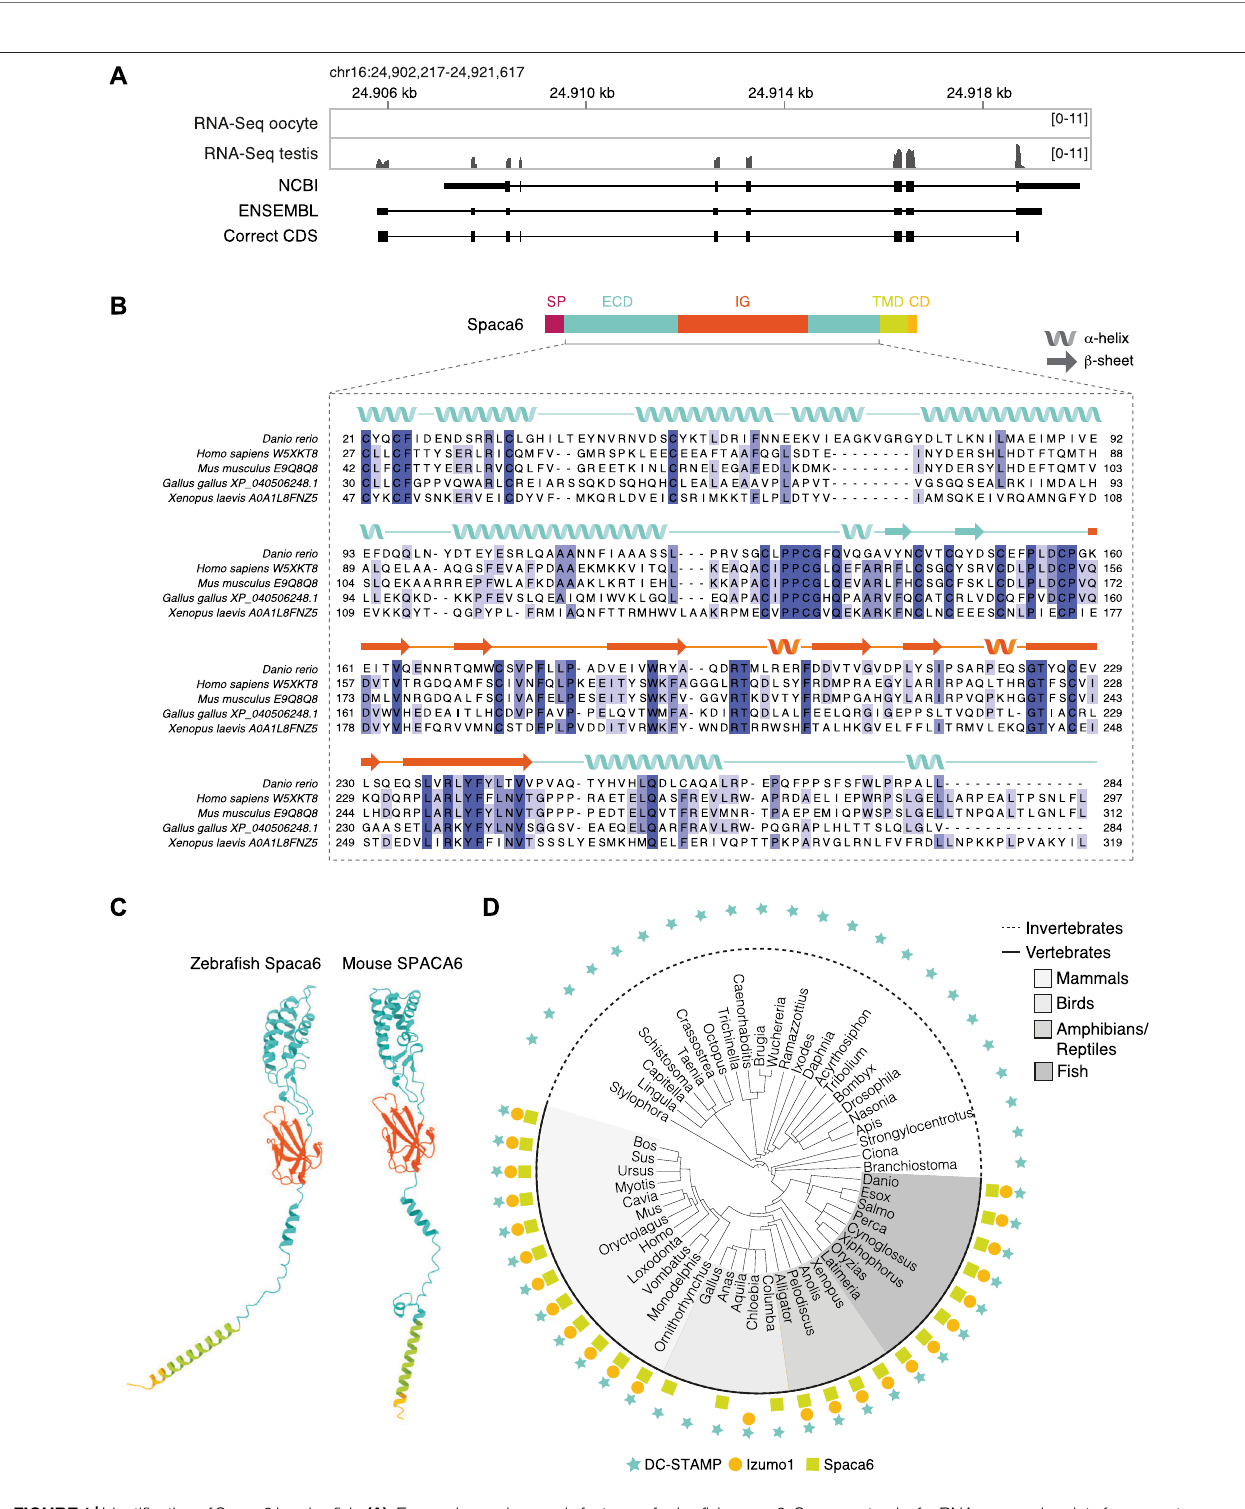
FIGURE1| Identi fi cationofSpaca6inzebra fi sh. (A) .Expressionandgenomicfeaturesofzebra fi sh spaca6 .CoveragetracksforRNAsequencingdatafromoocyte and testis aligned with ENSEMBL (ENSDART00000155083.2) and NCBI (XM_021466914.1) annotations as well as the full-length, newly identi fi ed testis coding DNA sequence (correct CDS). Genomic coordinates are based on GRCz11. (B) . Protein domain structure of full-length Spaca6 and sequence alignment of the mature extracellular region of selected vertebrate Spaca6 proteins. Secondary structure prediction of the zebra fi sh Spaca6 protein sequence is depicted above the sequencealignment(coil:alpha-helix;arrow:beta-sheet).Theextracellulardomain(ECD)isshowninblue,whiletheImmunoglobulin-likedomain(IG)isshowninorange. SP, signal peptide; TMD, Transmembrane domain; CD, Cytoplasmic domain. (C) . Tertiary structure predictions of mouse and zebra fi sh Spaca6. Protein folding